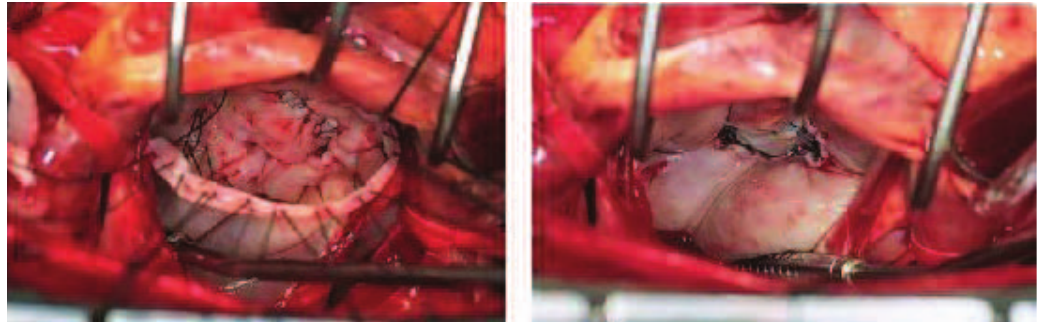
Figure 1 - Technique of posterior annuloplasty with bovine pericardial